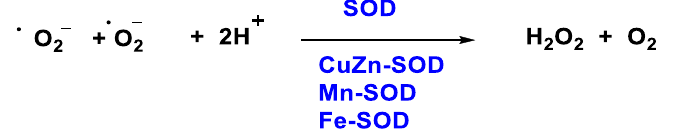
Figure 3. H 2 O 2 production through SOD enzyme.